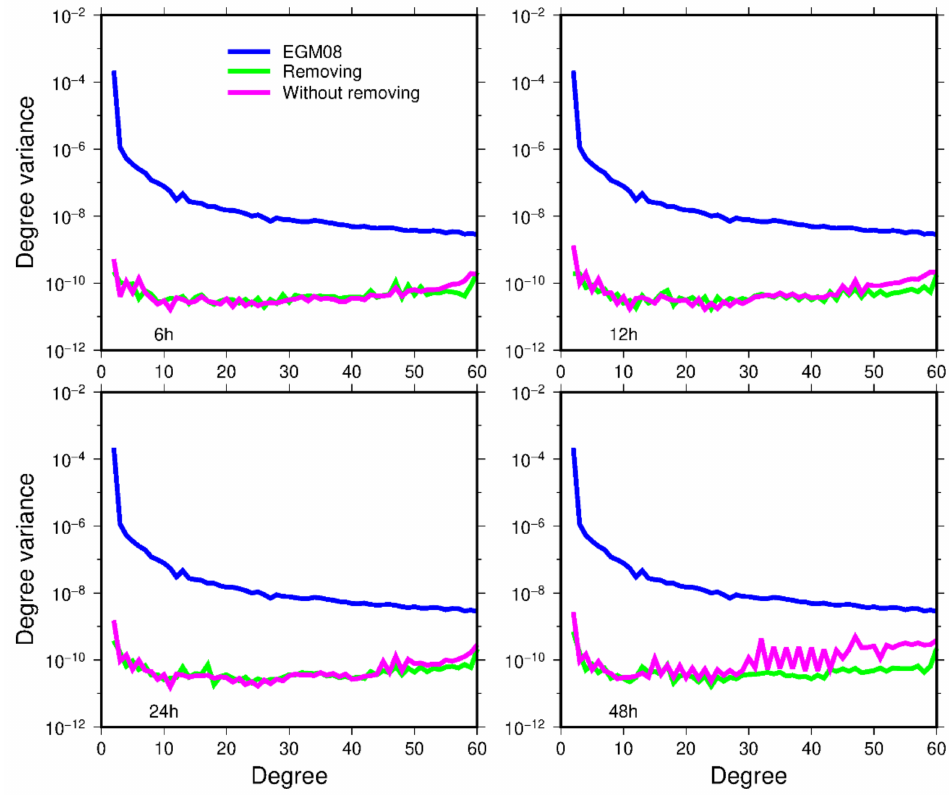
Figure 5. The degree variance of the recovered gravity field by using 6, 12, 24 and 48 h arcs, when combining the orbit data and the range rate data to recover the gravity